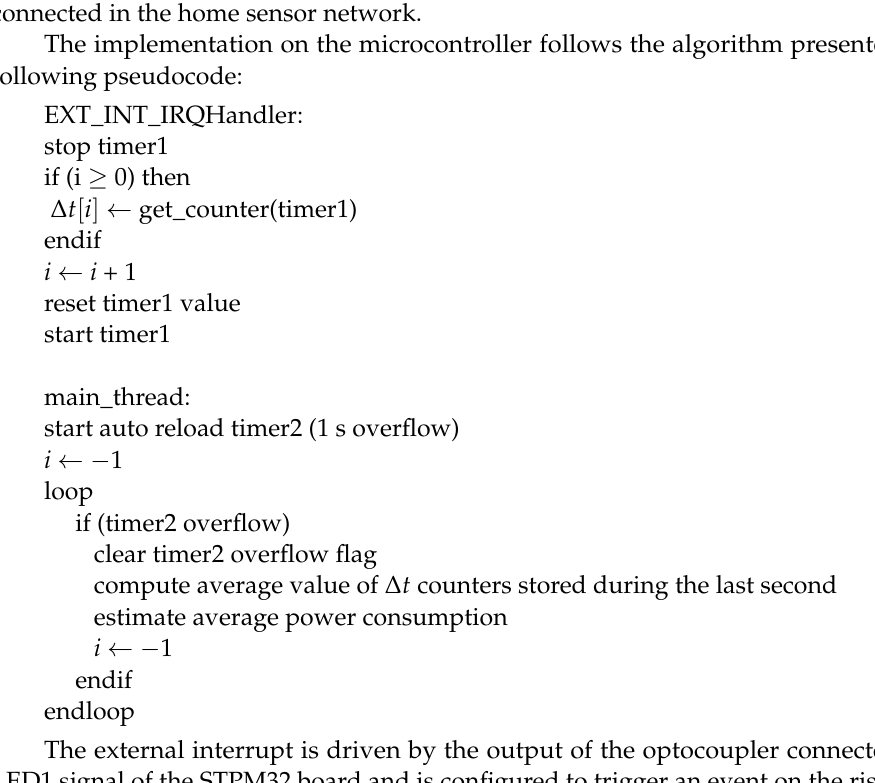
Figure 12. Interfacing board block diagram (CMU—charging management unit, OC—optocoupler,